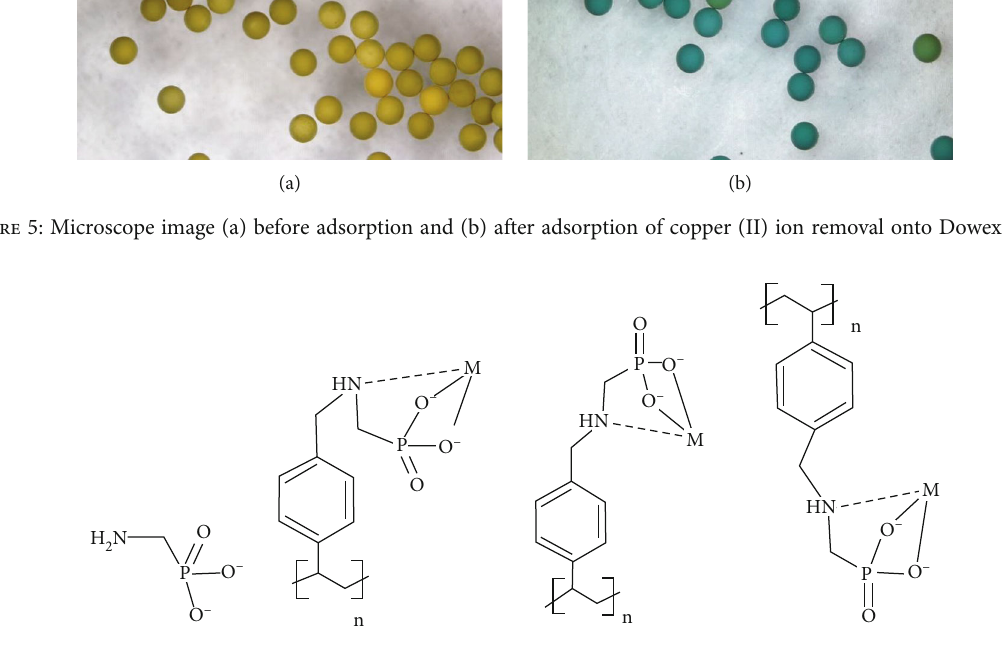
Figure 6: Aminomethyl phosphonic/methyl phosphonic functional group.